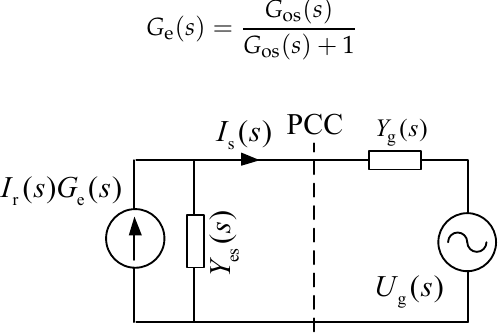
Figure 3. System equivalent Norton model.